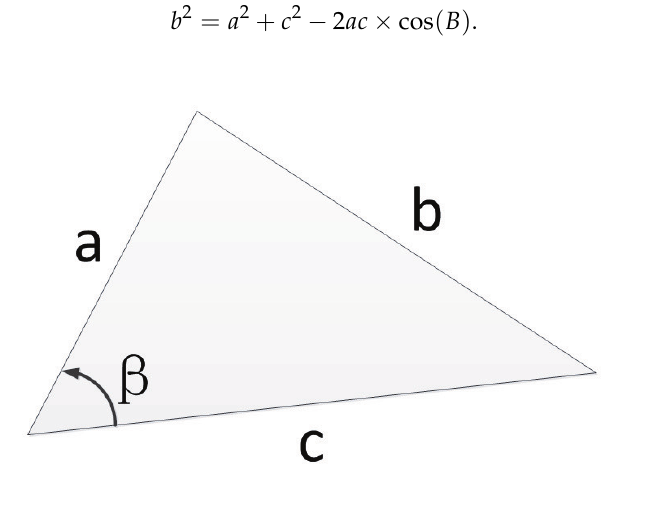
Figure 6. Cosine